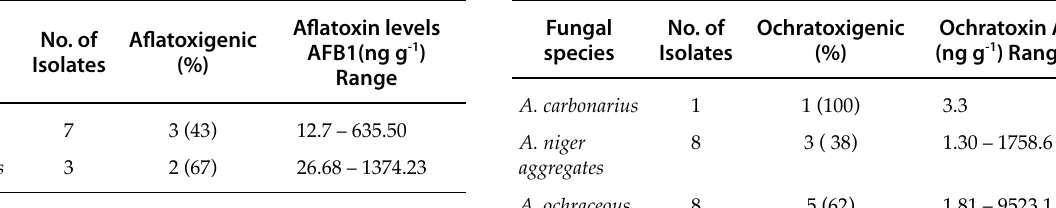
Table 3. Toxigenic potential of aflatoxigenic fungi isolated from maize